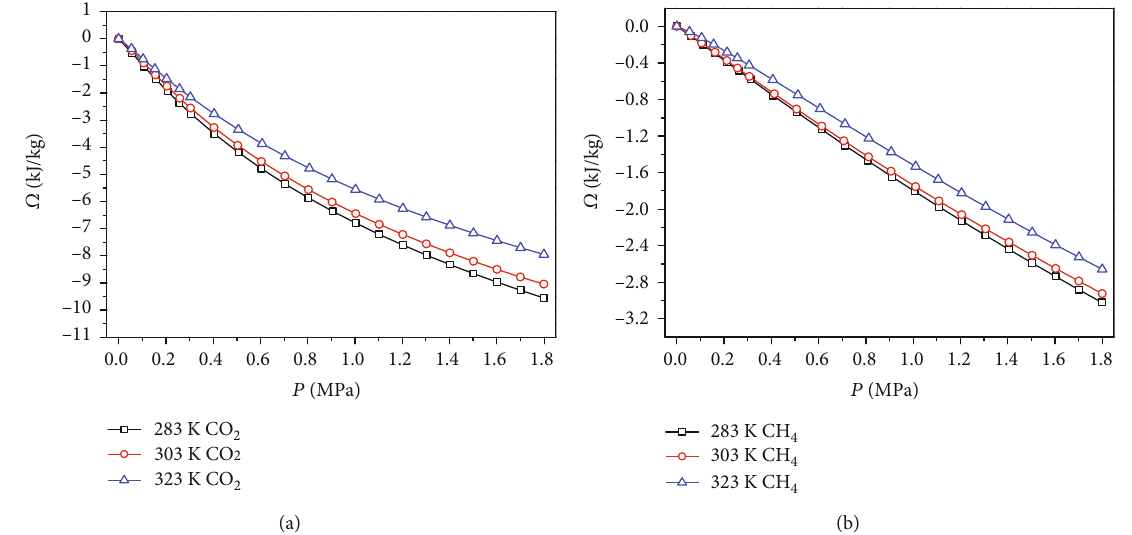
Figure 8: Surface potentials of CO